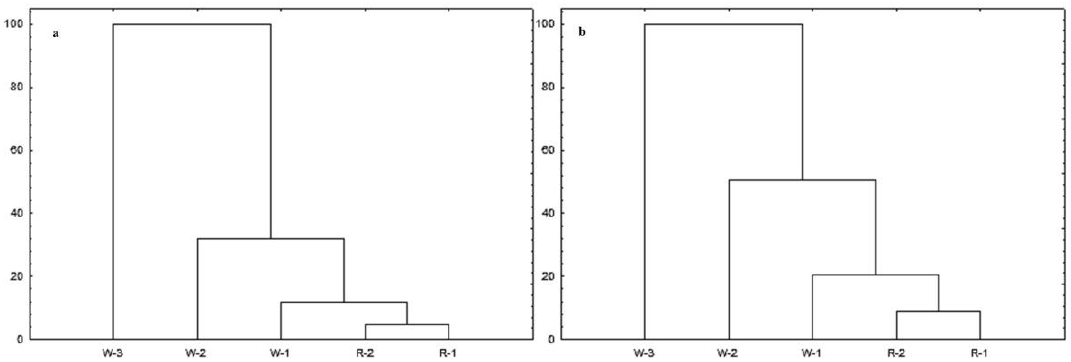
Figure 5. Dendrogram of cluster analysis of willow and rape honeys; ( a ) dendrogram after UAE in 366 nm; ( b ) dendrogram after SPE in 254 nm. (W—willow honeys; R—rape honeys). 366 nm; ( b ) dendrogram after SPE in 254 nm. (W—willow honeys; R—rape